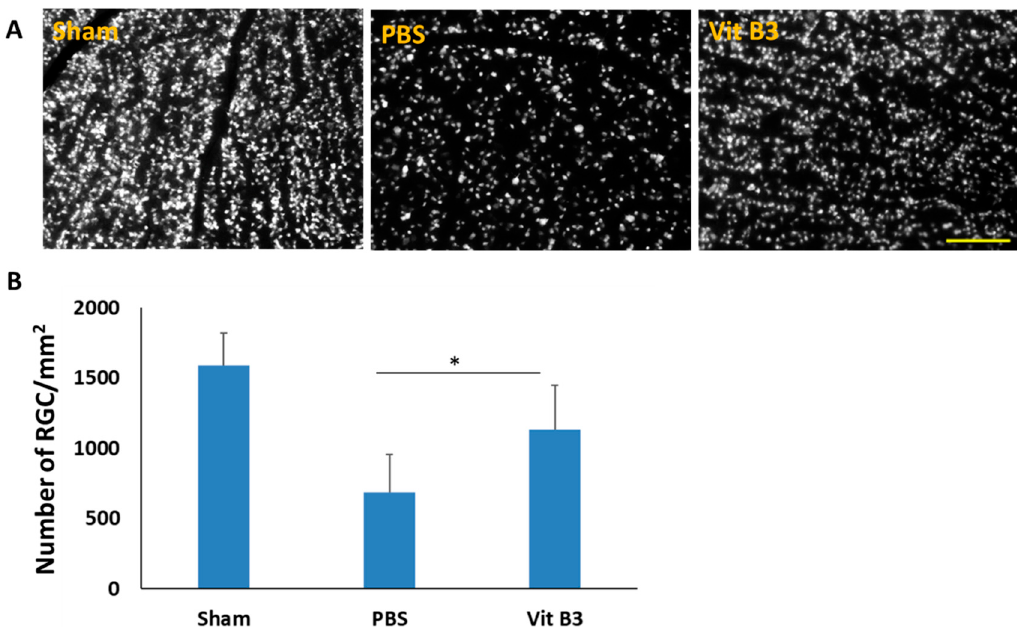
Figure 2. Vitamin B3’s impact on RGCs 28 days after an ON infarction. ( A ) Fluorogold-labeled RGC density that is typical for each group. ( B ) Following rAION induction, a bar chart revealed that the RGC density in the vitamin B3-treated group was considerably higher than that in the PBS-treated group (* p < 0.05; n = 6 per group; scale bar: 200 μ m). Data were presented as mean ± SD.